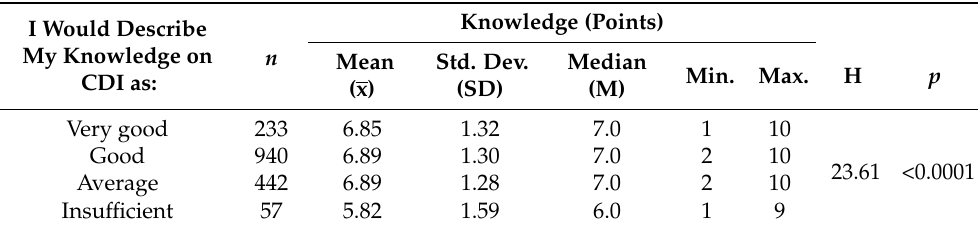
Table 6. Descriptive statistics on the knowledge level of the respondents with different self-evaluation of their knowledge on CDI and the Kruskal–Wallis test results (H).